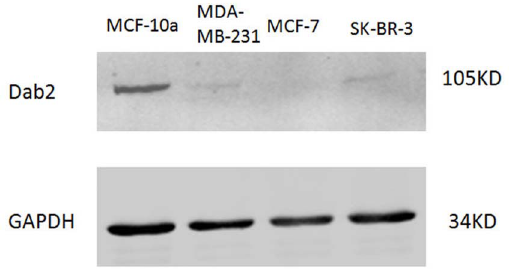
Figure 2. Dab2 protein expression in three breast cancer cell lines demonstrated by western blots. Western blot analysis of Dab2 protein expression in breast cancer cell lines. None of the 3 breast cancer cell lines showed detectable levels of Dab2 protein, while the nonmalignant mammary epithelial cell line MCF10A (positive control) showed the presence of Dab2 protein. Results were representative of 3